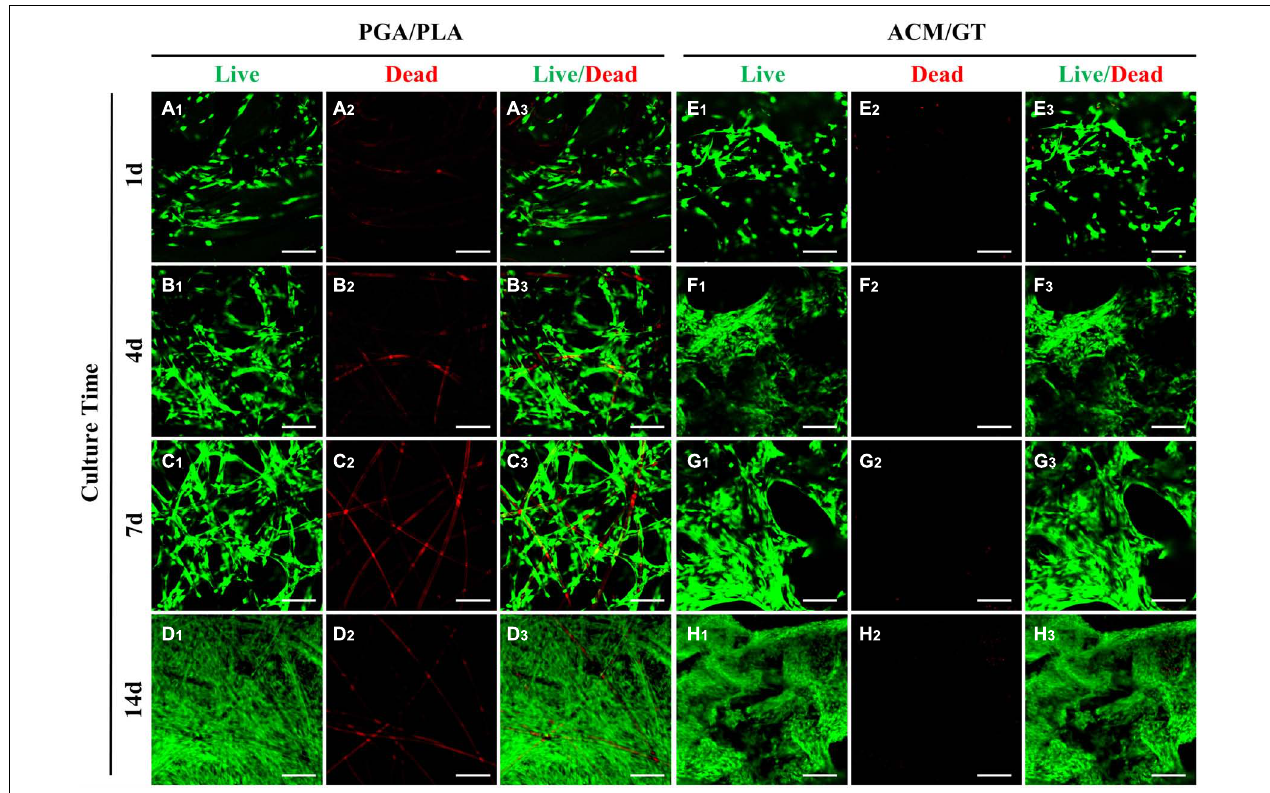
FIGURE 2 | Evaluation of cell viability on the scaffolds. Live/Dead staining showed the number of chondrocytes gradually increased on the PGA/PLA scaffold (A–D) and ACM/GT scaffold (E–H) as the culture time increased in vitro . Almost all chondrocytes survive well (green cells) and few dead cells (red cells) are observed at all observation points. The linear red color ( A 2 –D 2 , non-specific staining) is the PGA fibers. Scale bar: 100 µ